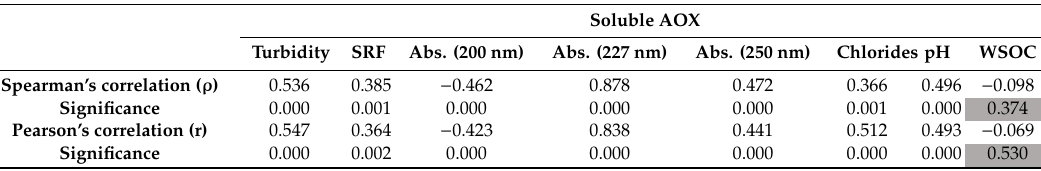
Table 2. Spearman and Pearson correlations for the correlation of the independent variables with soluble AOX